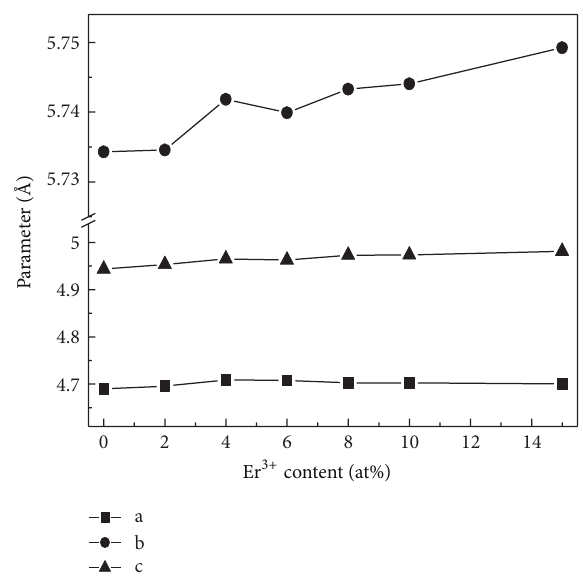
Figure 2: Cell parameter versus Er